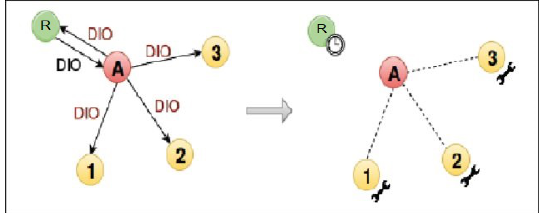
Figure 6. Version number modification